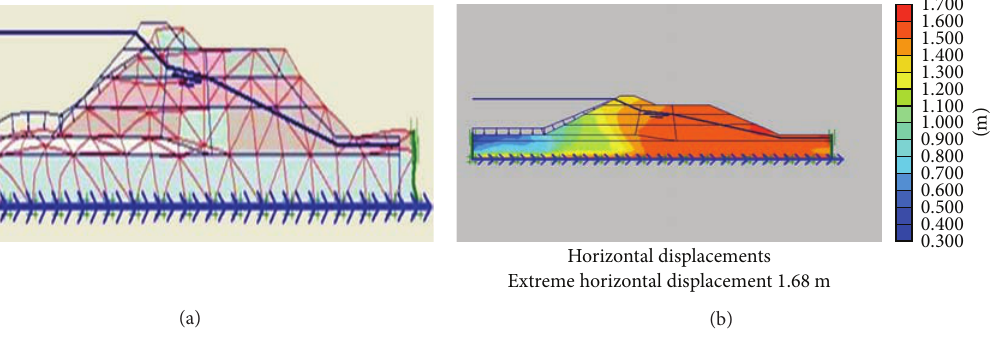
Figure 7: Whole deformations and horizontal displacements of Upper San Fernando